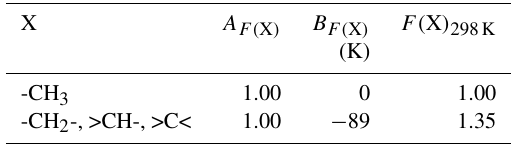
Table 3. Ring factors, F ring , for the reactions of OH with cyclic alkanes, and their temperature dependences described by F ring